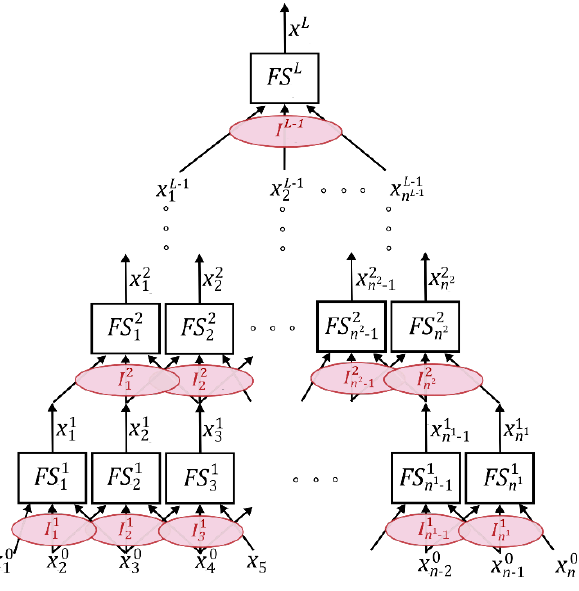
Figure 3. General structure of a DCFS with moving window size 𝑚 𝑙 = 3 .